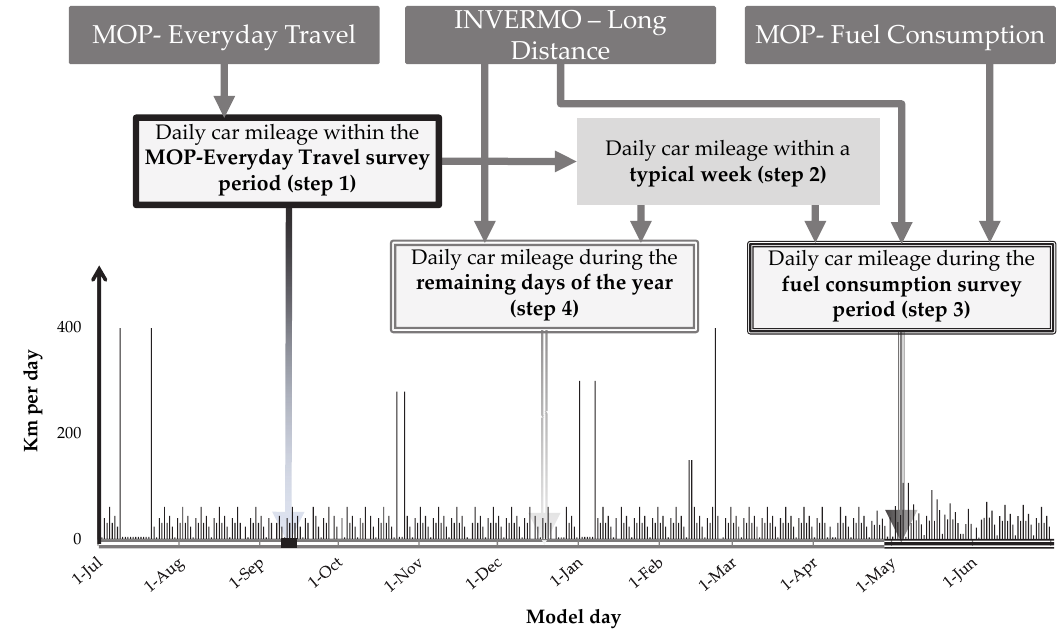
Figure 1. Structure of CUMILE visualizing the model results for one